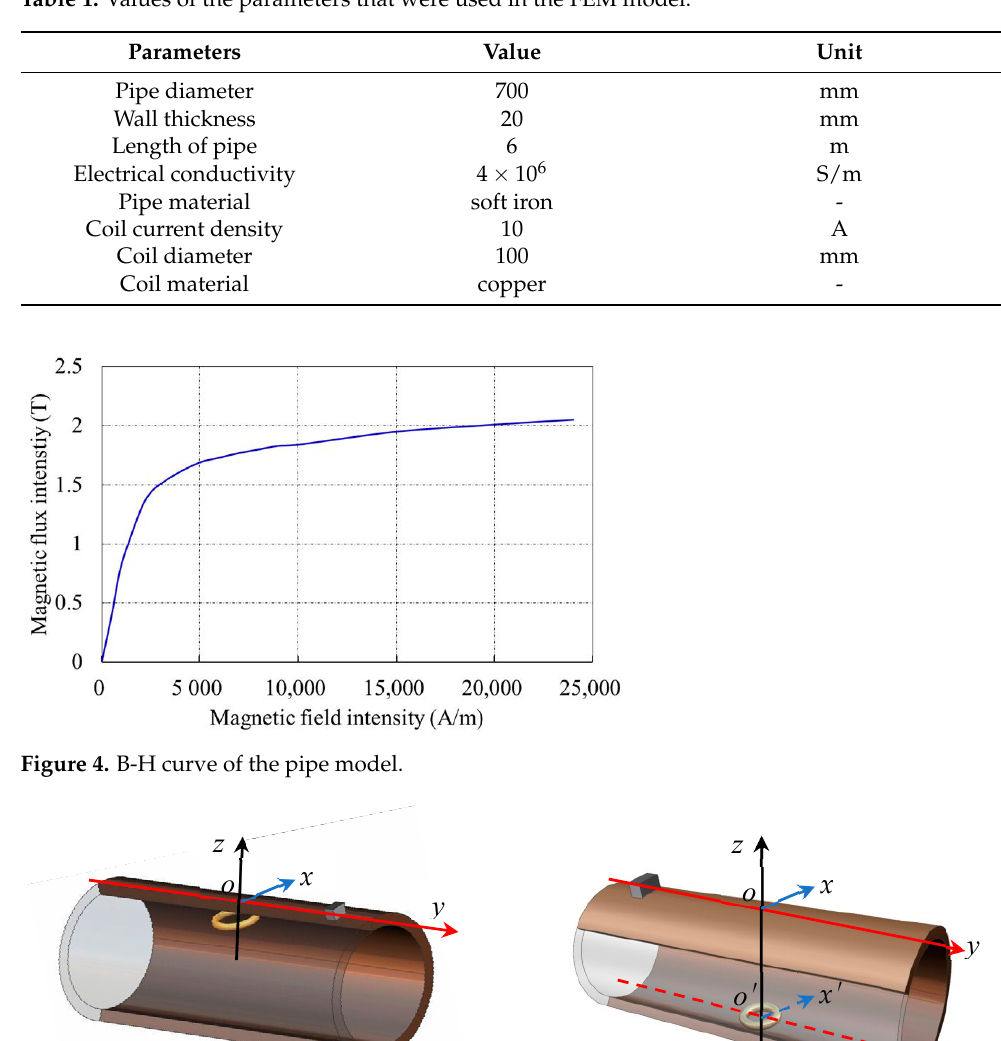
Figure 5. Position of the current-carrying coil. ( a ) On the top of the inner wall of the pipe. ( b ) At the bottom of the inner wall of the pipe.